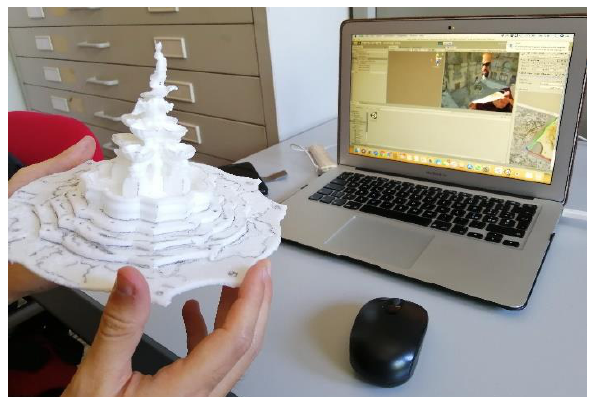
Figure 9. The 3D printed model of the Garraffo fountain with the targets drawn on the